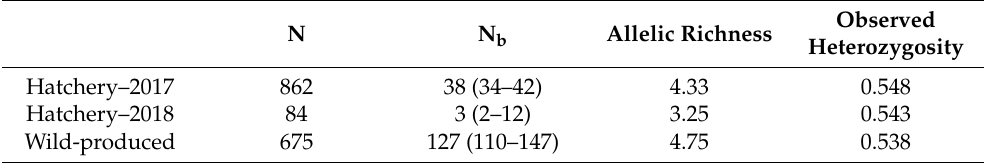
Table 2. Genetic diversity comparison between hatchery-produced offspring in 2017 and 2018 and wild-produced offspring in 2018. No significant differences were observed at any of the genetic diversity measures. Sample sizes (N) and estimated number of breeders (N b ) with 95% confidence intervals are included. Observed N N b Allelic Richness